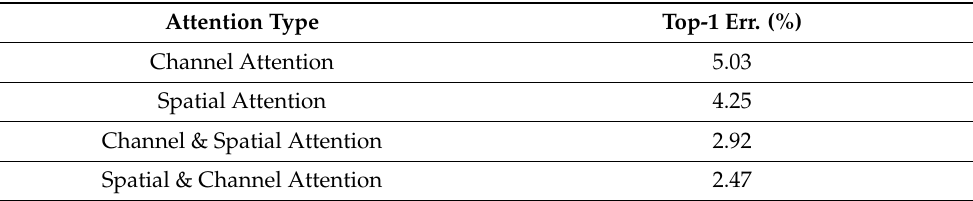
Table 3. Classification error (%) on SEM Hair dataset.